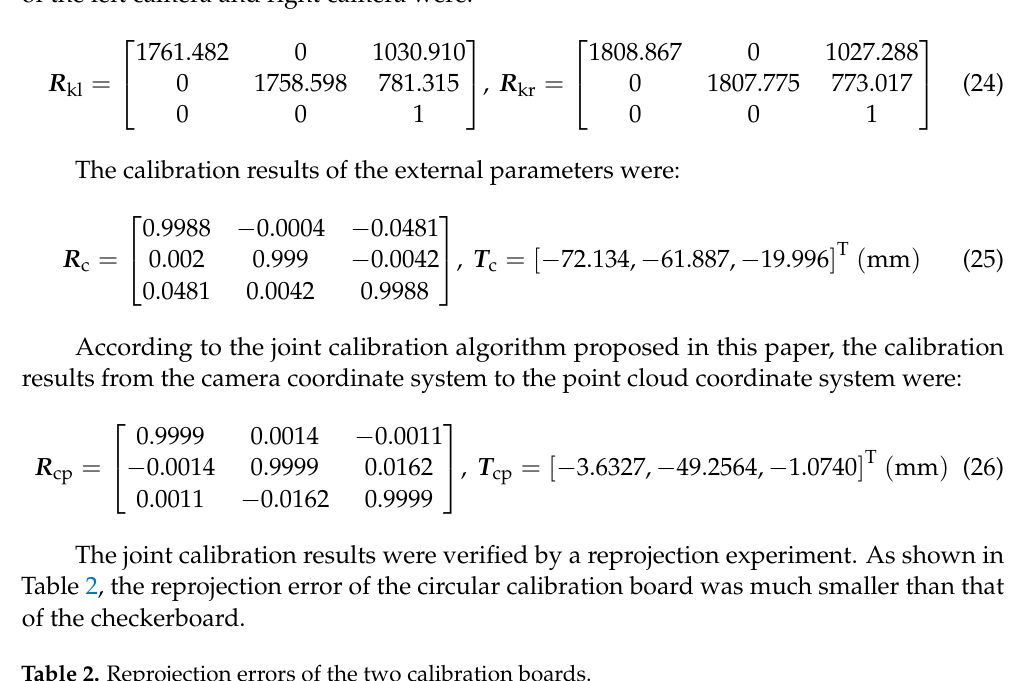
Table 2. Reprojection errors of the two calibration boards.